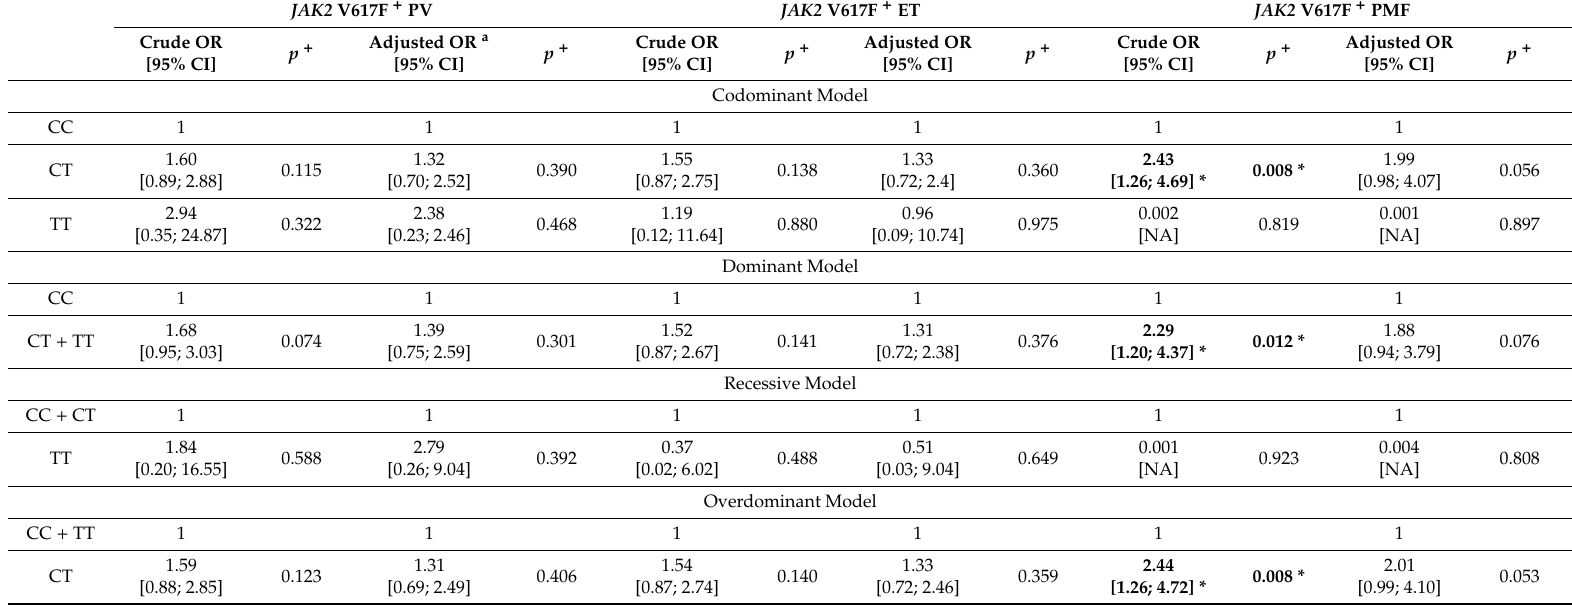
Table 4. Associations between TET2 rs154843 SNP and MPN molecular subtypes determined by JAK2 V617F mutation: multinomial logistic regression